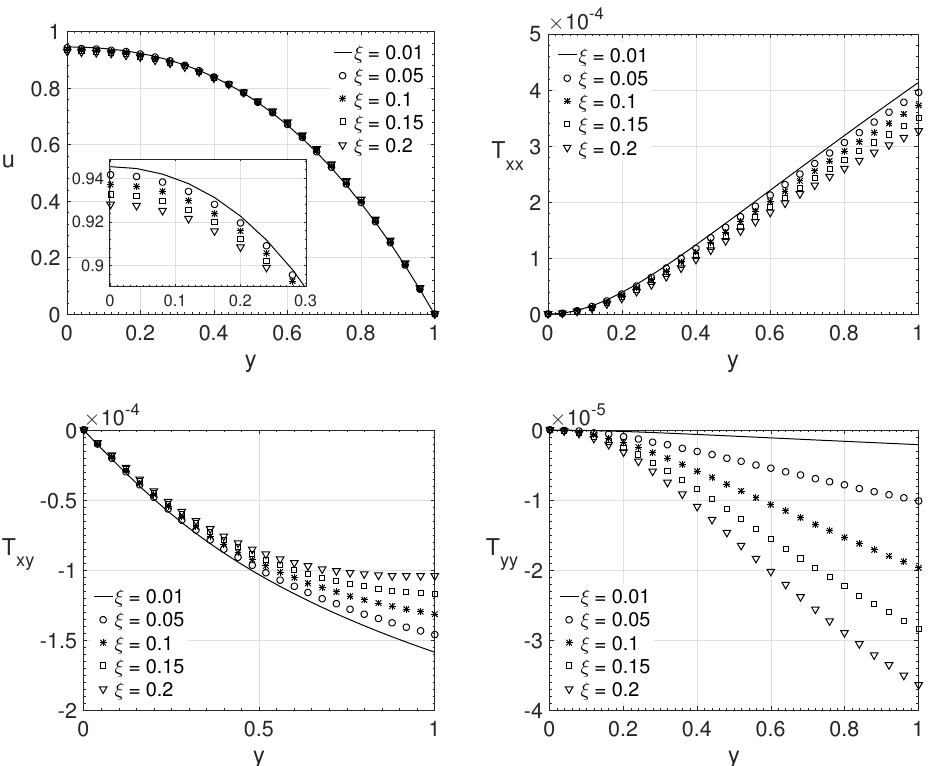
Figure 8. ξ influence on the wall-normal variation y of the streamwise velocity component u and the extra-stress tensor components T xx , T xy and T yy . Dimensionless parameters: Re = 3000, β = 0.25, (cid:101) = 0.75 and Wi = 2.